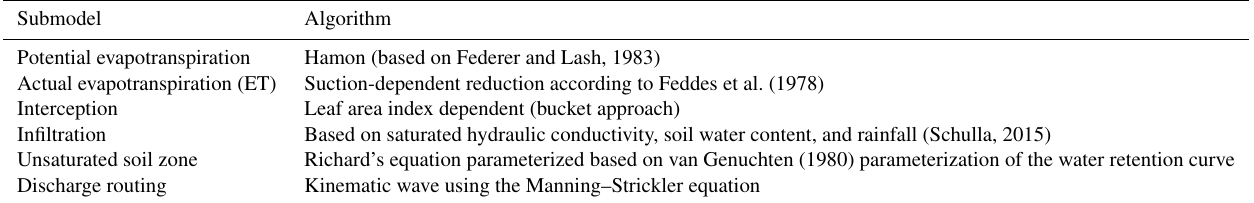
Table 2. Selected submodels and algorithms of WaSiM. Submodel Algorithm Potential evapotranspiration Hamon (based on Federer and Lash, 1983) Actual evapotranspiration (ET) Interception Leaf area index dependent (bucket